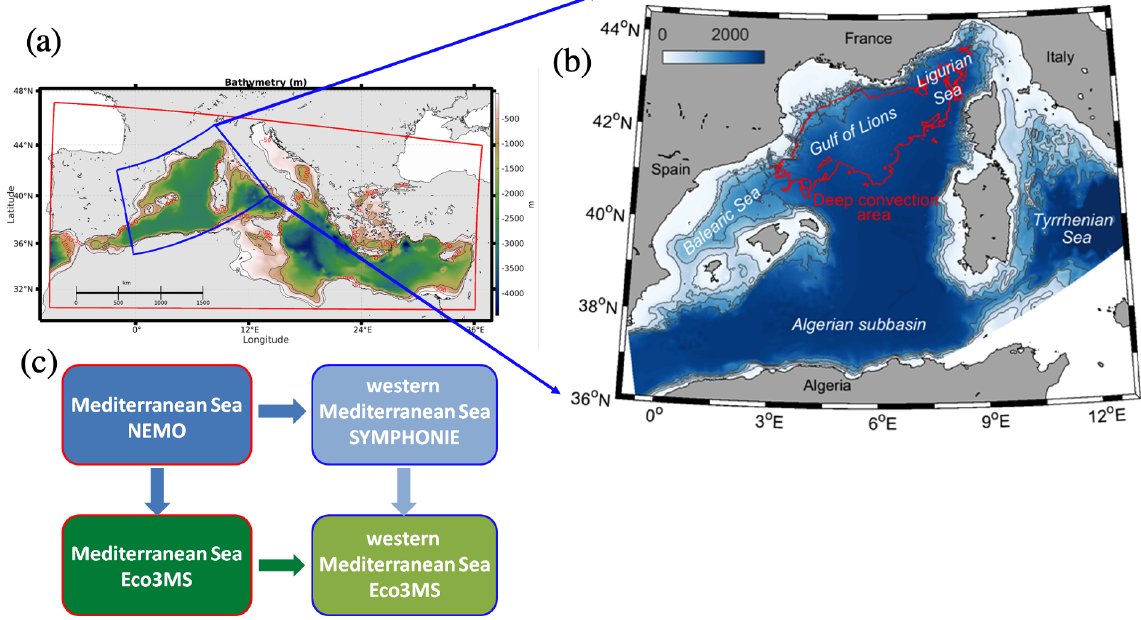
Figure 1. Domain and bathymetry (m) of (a) the forcing coupled NEMO-Eco3MS Mediterranean model (red contour) and of (b) the coupled SYMPHONIE-Eco3MS western sub-basin model. The blue contour in (a) indicates the limits of the western sub-basin model. The red contoured area in (b) corresponds to the deep-convection area. (c) Scheme of the downscaling strategy from the Mediterranean Sea to the western